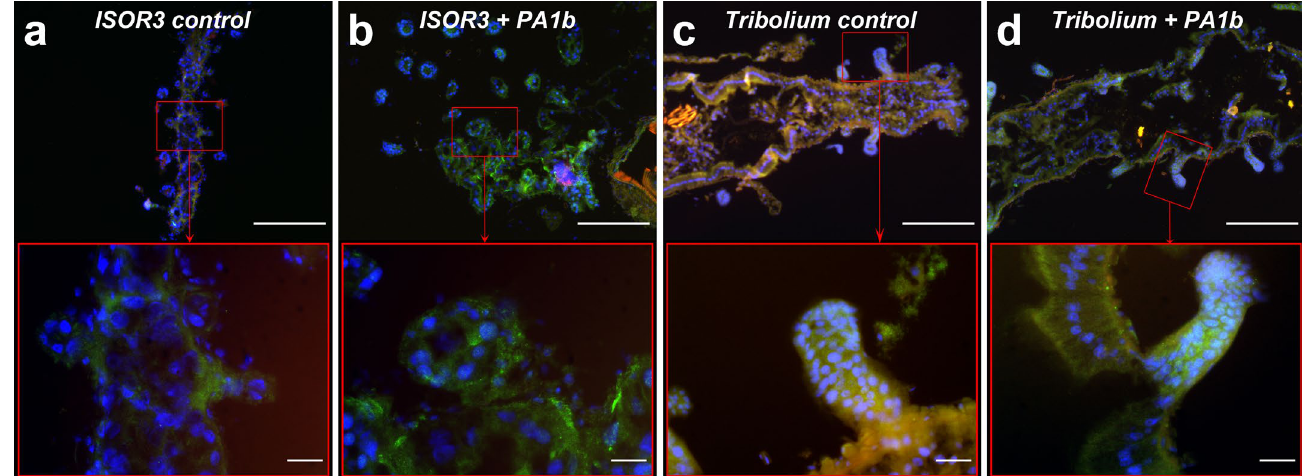
Figure 7. Immuno-localization of the caspase-3 active form in resistant S. oryzae (strain ISOR3) and in the insensitive insect T. castaneum , intoxicated with PA1b. Insect midguts were dissected, embedded, frozen and then tissue sections (7 µ m) were cut. Slides were prepared as described in the Experimental Procedures section. Caspase-3 was labelled with rabbit anti-cleaved caspase-3 and revealed using a secondary antibody Alexa fluor 488 donkey anti-rabbit IgG. DAPI was added for nuclear staining. The midgut of the resistant weevil strain ISOR3 reared on wheat flour (control, a ) or intoxicated with PA1b, at 400 µ g per g of food, for 4 days ( b ); the midgut of the insensitive insect T. castaneum reared on wheat flour (control, c ) or intoxicated with PA1b, at 400